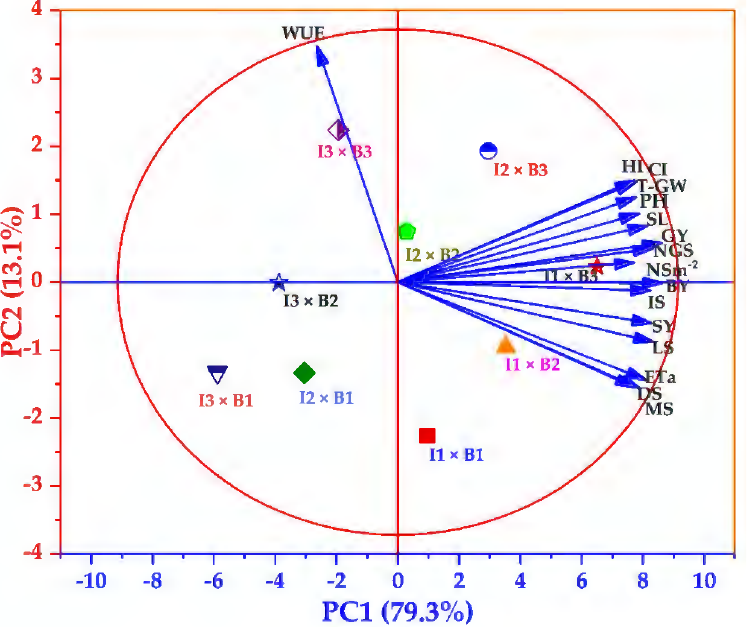
Figure 9. Biplot of the principal component analysis (PCA) of wheat plants subjected to biochar soil supplementation (0 (B 1 ), 7.5 (B 2 ), and 15 t ha − 1 (B 3 )) under three levels of irrigation (100 (I1), 80 (I2), and 60% (I3) of ETC). The first and second principal components (PC1 and PC2) represented 92.4%. The vectors show the studied traits and the coloured shapes explained various treatments. Grain yield (GY), ETa at initial stage (IS), ETa at development stage (DS), ETa at mid − stage (MS), ETa at late stage (LS), actual evapotranspiration (ETa), plant height (PH), spike length (SL), number of grains spike − 1 (NGS), number of spikes m − 2 (NS m − 2 ), 1000 − grain weight (T − GW), biological yield (BY), straw yield (SY), harvest index (HI), crop index (CI), water use efficiency